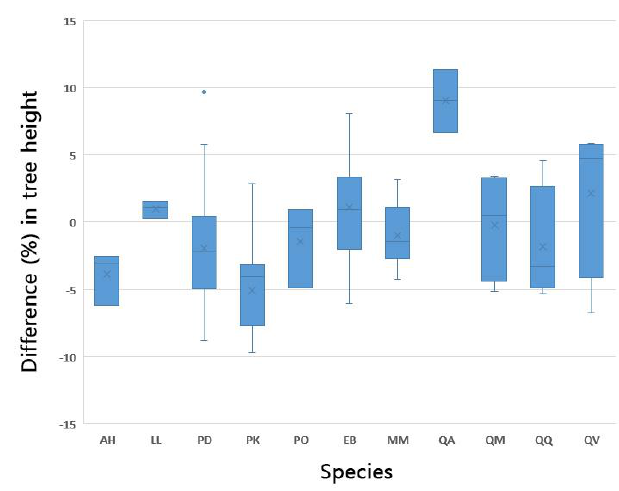
Figure 5. Differences in tree heights between tree height class and ALS H max according to stand. (AH: